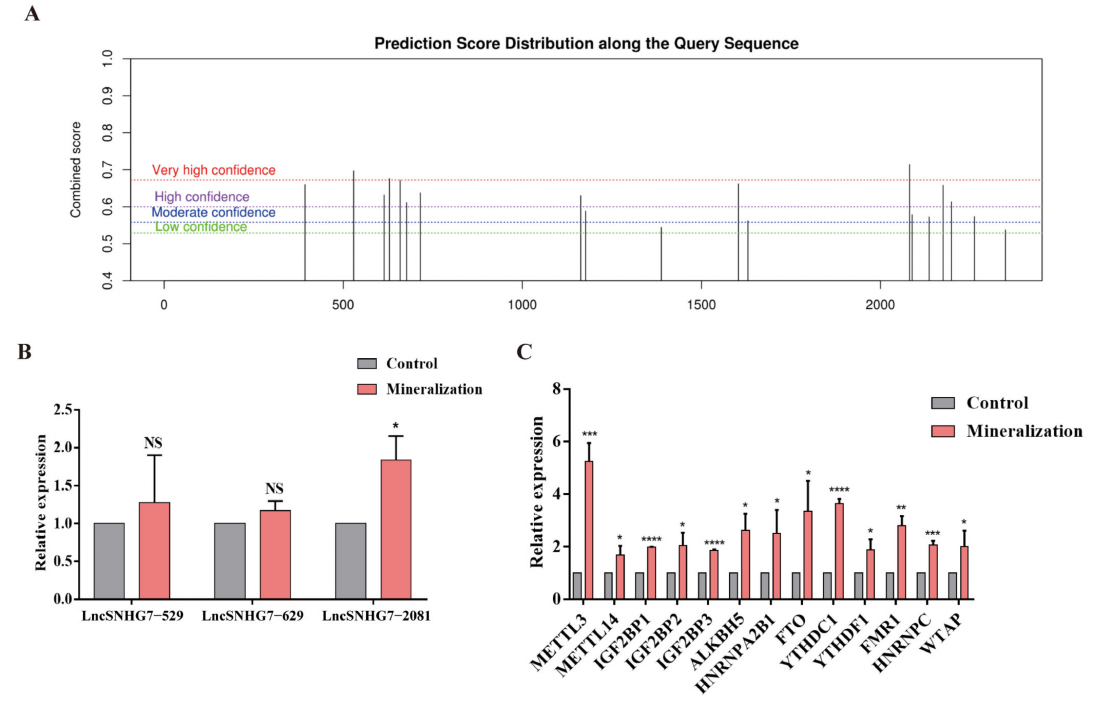
Figure 2. The m 6 A modification on lncSNHG7. ( A ) The m 6 A prediction score distribution of lncSNHG7 predicted by SRAMP website tools. ( B ) Single base site PCR (MazF) analysis was used to confirm the m 6 A modification site of lncSNHG7 after mineralization. ( C ) mRNA expressions of m 6 A modification-related enzymes detected by qRT-PCR. The data were represented as means ± SD for each group: * p < 0.05, ** p < 0.01, *** p < 0.001, **** p < 0.0001. NS: Not Statistically